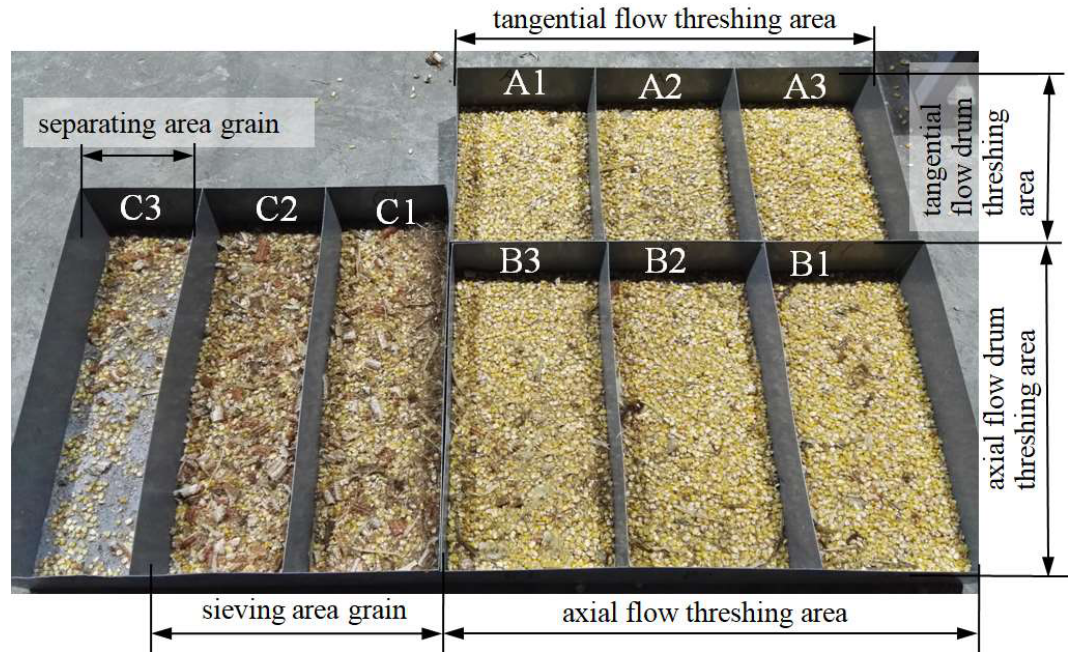
Figure 7. Threshing grain collection.